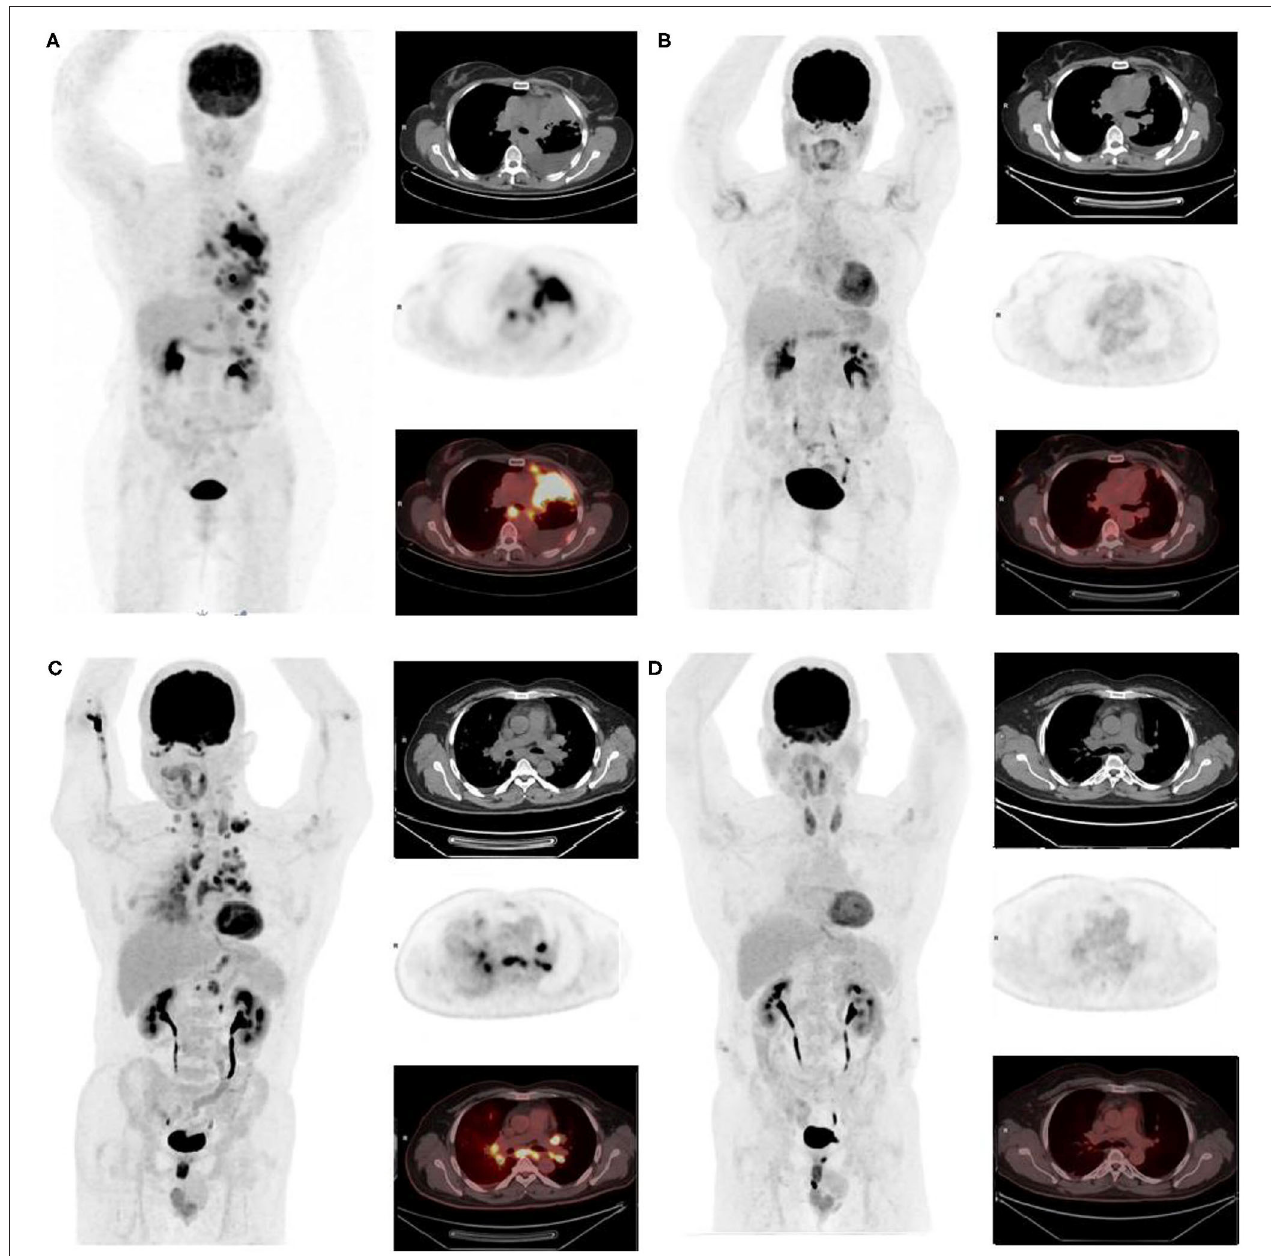
FIGURE 1 | First, we report a non-smoker, 81-year-old African woman, diagnosed with ALK-rearranged lung adenocarcinoma on progressive dyspnea and fatigue with performance status (PS) = 2. A baseline 18 F-FDG-PET/CT was performed, confirming a metabolic metastatic disease (left pleural nodes with pleurisy associated with upper and lower diaphragmatic lymph nodes) (A) maximum intensity projection image, chest CT, 18 F-FDG-PET, and fused 18 F-FDG-PET /CT . After 3 months of crizotinib, clinical improvement of the patient was observed (PS = 1 and disappearance of dyspnea) supported by a CMR on 18 F-FDG-PET as well as a CR on CT. This response was maintained for at least 28 months (B) . The other patient is a non-smoker, 58-year-old Asian man with a previous medical history of controlled arterial hypertension and pruritus ani, diagnosed with ROS1 rearrangement NSCLC adenocarcinoma. Staging 18 F-FDG-PET/CT showed multiple hypermetabolic lymph nodes and lymphangitic carcinomatosis (C) . After 3 months of crizotinib, 18 F-FDG-PET and CT showed respectively CMR and CR (D) that was still maintained 10 months later which corroborate the improvement of patient’s performance status (2 to 0).